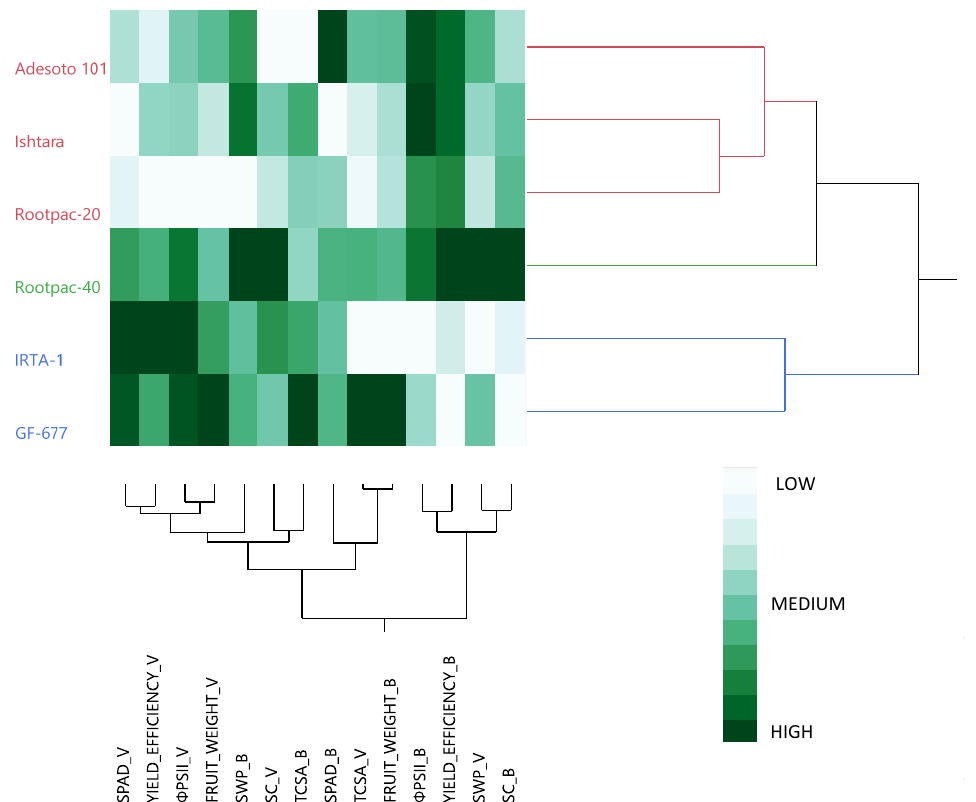
Figure 4. Clustering the six common rootstocks based on the most relevant traits evaluated. Data about their physiological parameters were collected from the last date of the evaluations applied to both cultivars. The same nomenclature has been used for both cultivars: fruit weight and yield efficiency for ‘Vairo’ almond cultivar represent kernel weight and kernel yield efficiency, as shown in Table 4. The letter V after each of the traits evaluated refers to ‘Vairo’ and the B refers to ‘Big Top’.